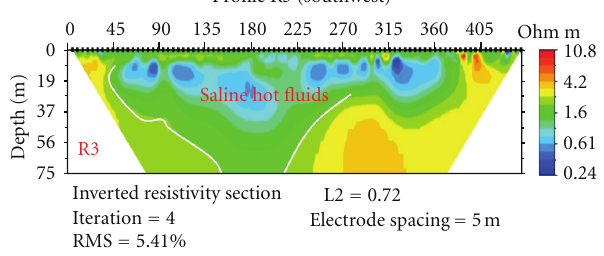
Figure 8: Inverted 2D resistivity section for profile 3 between fault A and fault B in the southwest of Lake Magadi.